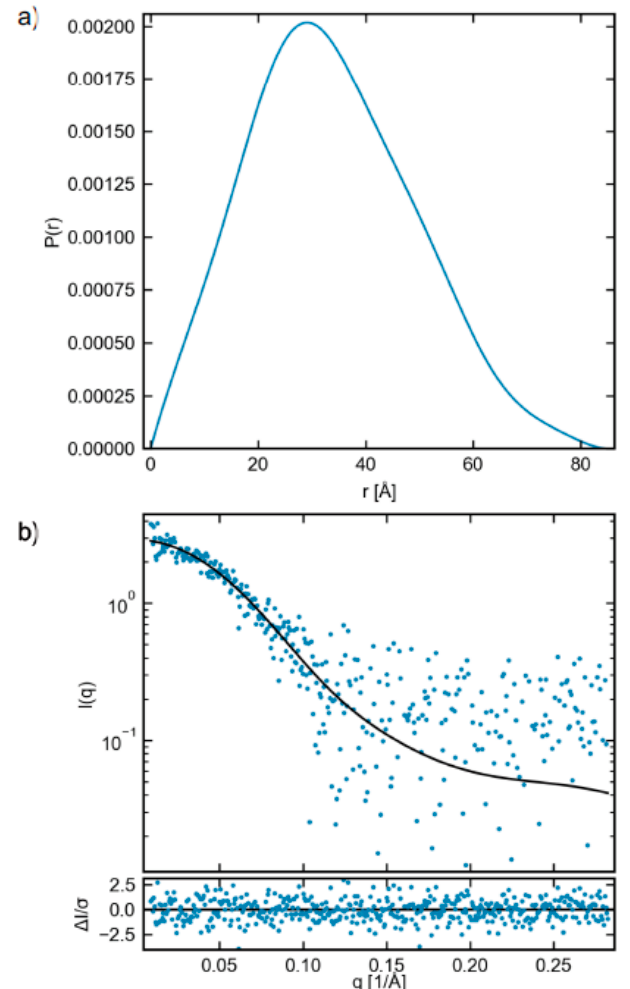
Figure 5. ( a ) P(r) function (blue line) as calculated from the SAXS data, normalized by I(0). ( b ) The scattering profile (blue points), fit to the data from the P(r) function (black line), and normalized fit residual (bottom panel).